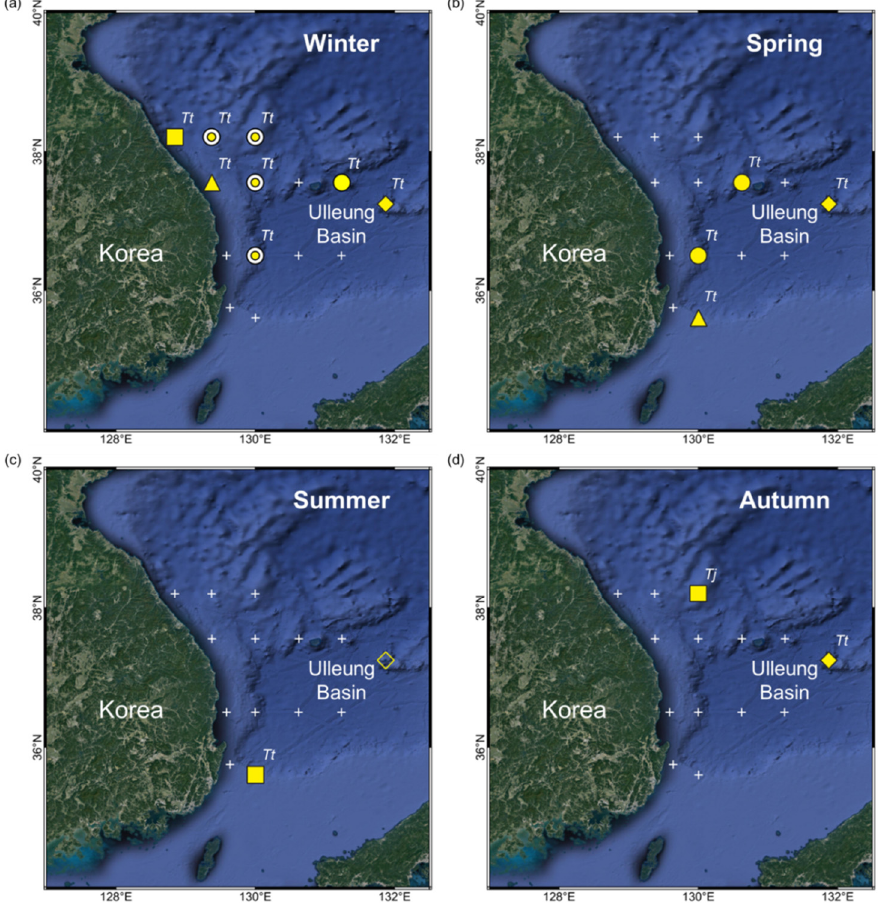
Figure 4. Distributions of pelagic eggs of two Trachipterus species for the four seasons: ( a ) winter, ( b ) spring, ( c ) summer, and ( d ) autumn. Tt , T. trachypterus ; Tj , T. jacksonensis ; Sampling year of Trachipterus eggs: filled circle, 2019; fisheye, 2019 and 2020; filled triangle, 2020; filled square, 2021 of this study; filled diamond, 2017–2019 of Shin et al. [41]; no egg detection: cross, this study; empty diamond, Shin et al. [41].